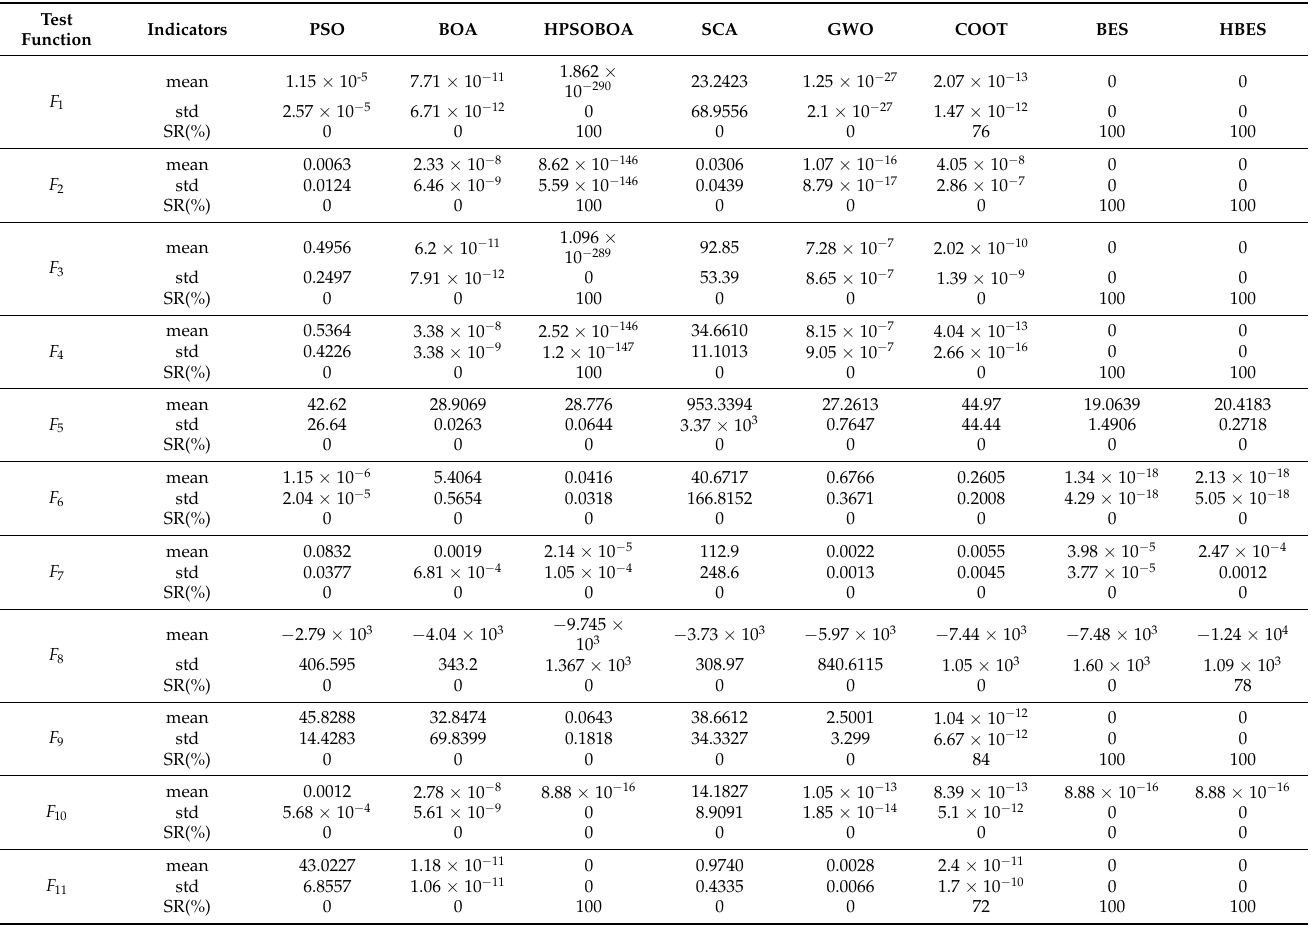
Table 2. Comparison of algorithm search